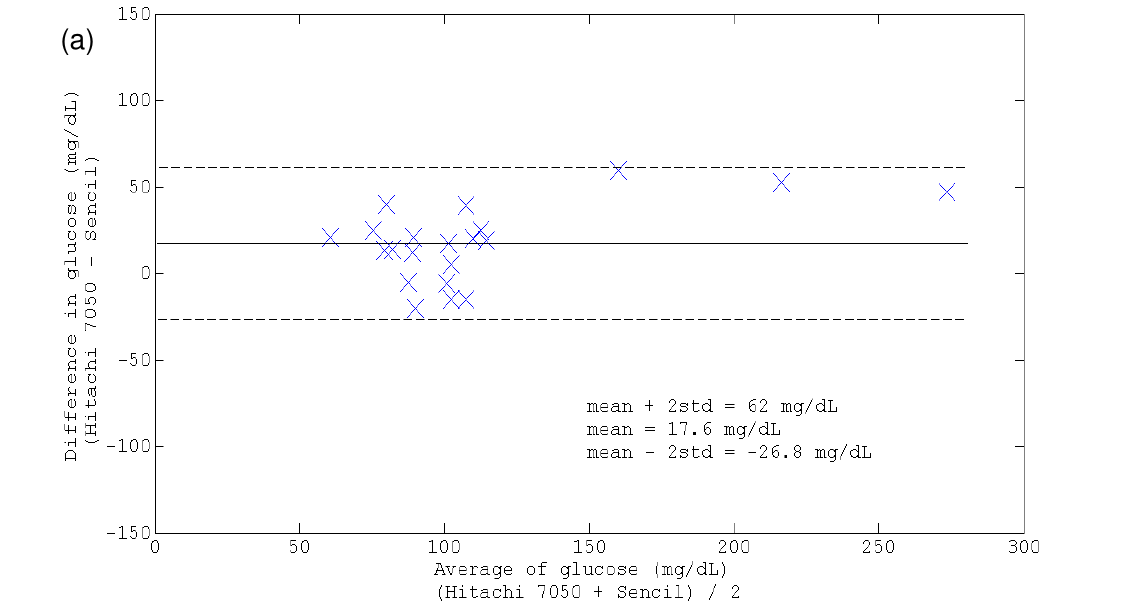
Figure 6. Accuracy of agreement between Sencil reading and plasma reference: (a) Bland-Altman method analysis; (b) least square linear fitting result; (c) Clarke error grid analysis.